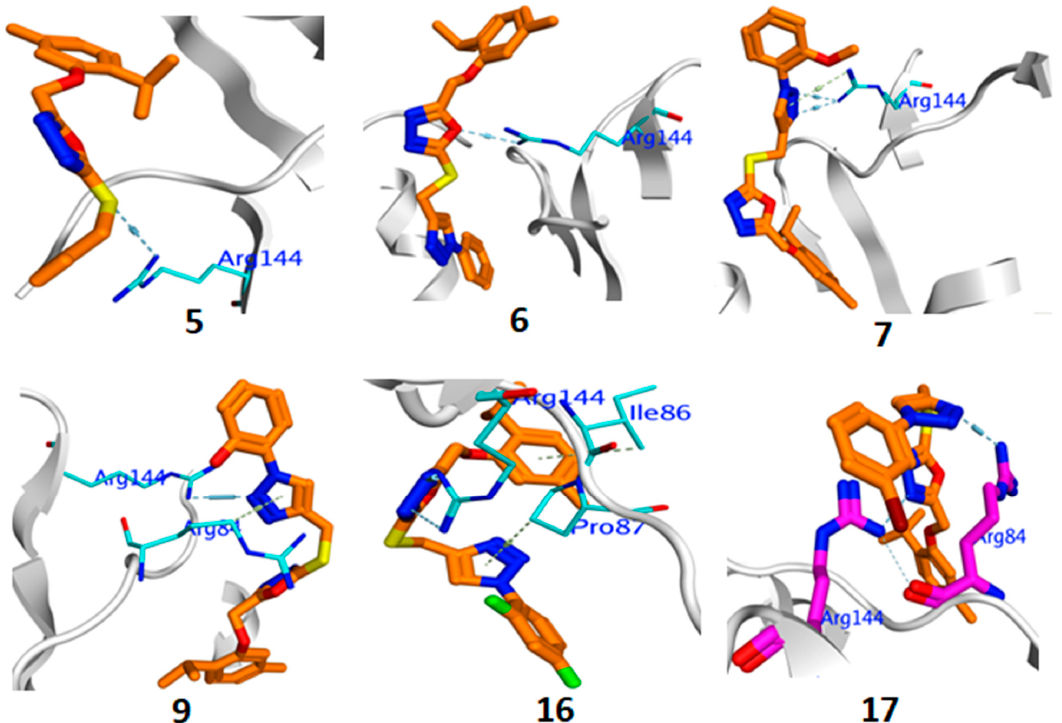
Figure 5. Binding interaction of active compounds against DNA gyrase (4URO).